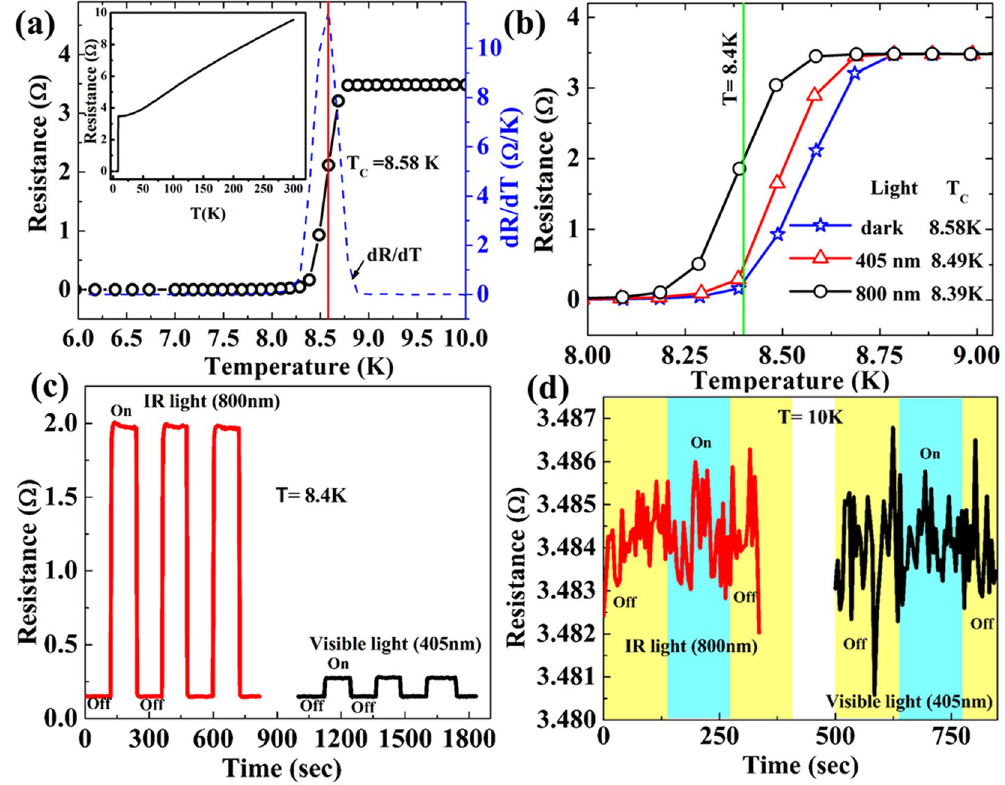
Figure 4. Effects of light on the low temperature transport properties. ( a ) R-T measurements in the dark condition. The T c , defined as the temperature corresponding to the maximum of dR/dT , is shown by the red vertical line indicating T c = 8.58 K . Inset: The full scale R-T data measured from room temperature 6 K. ( b ) R-T measurements with 405 nm and 800 nm wavelength lights along with the dark state R-T curve. ( c ) Real time response of the device resistance to light ‘On’ and ‘Off’ states at 8.4 K in the superconducting state of the device. The red and black curves indicate the resistance switching for 800 nm 405 nm lights, respectively. ( d ) Effects of the light on devices measured at 10 K in its metallic state. The color shades indicate the light ‘On’ and ‘Off’ states. No significant change in resistance observed at 10